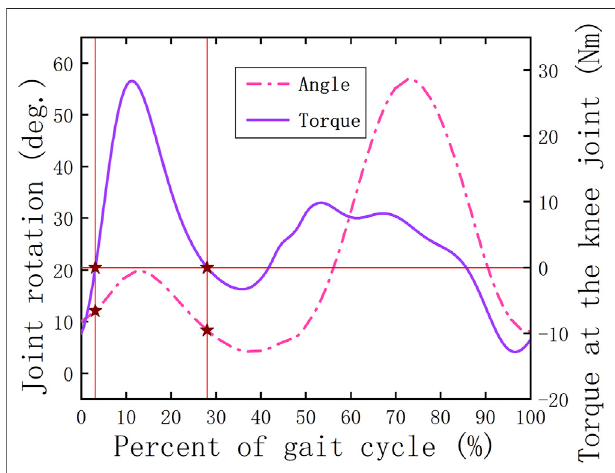
FIGURE1| Relationshipbetweenthejointtorque andangle fortheknee